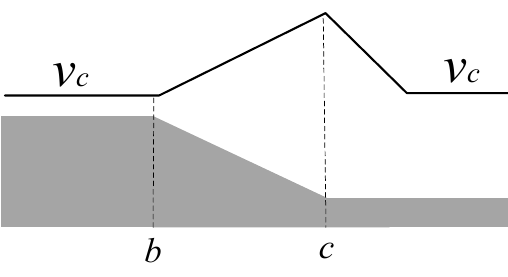
Figure 2. Train speed curve in a steep downhill